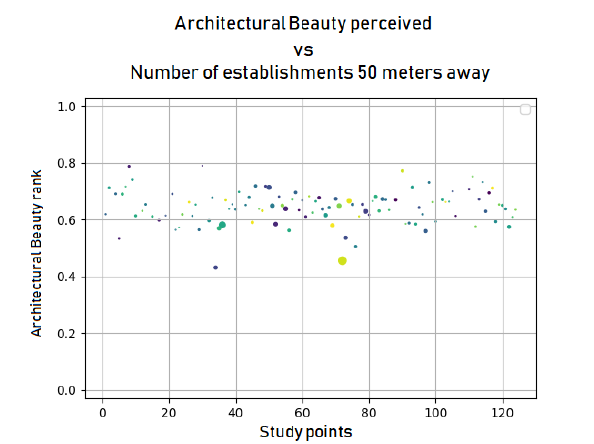
Figure 10. Safety perceived from the points of study. values from the INV and DENUE databases. Figures 11, 12 and 12 shows 3 of this correlations.